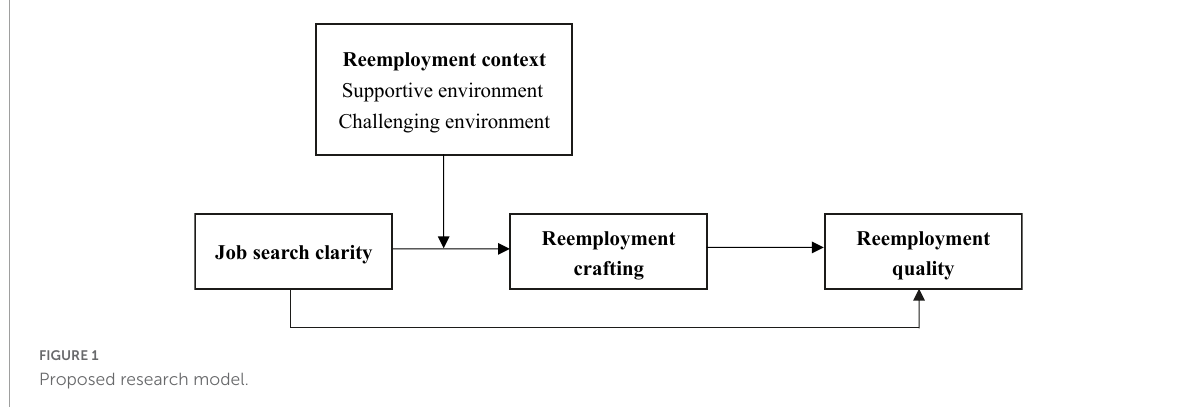
FIGURE1 Proposed research